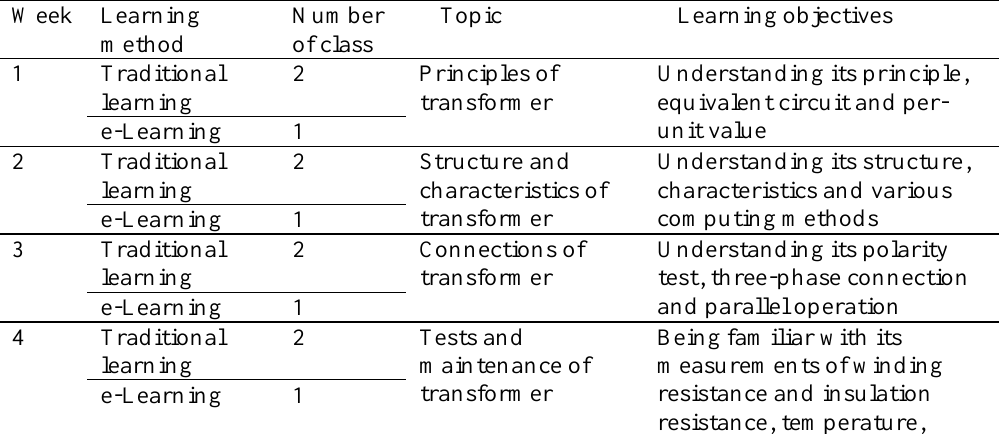
Experimental Procedure Week